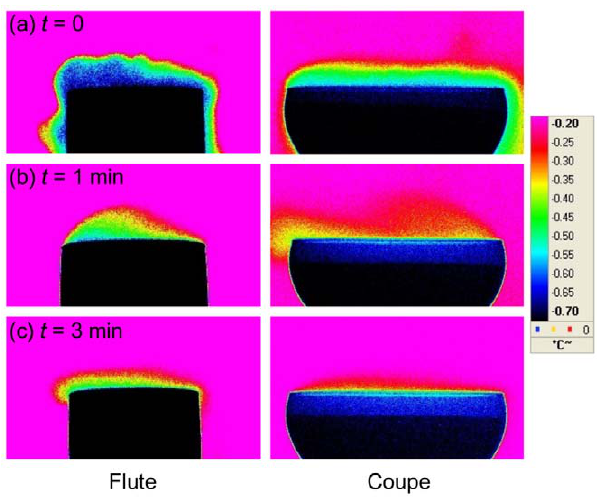
Figure 8. Close-up on gaseous CO 2 desorbing above both glass types. False color IR time-sequences showing close-up snapshots of CO 2 clouds desorbing above the flute and the coupe, respectively, immediately after pouring (a), 1 min after pouring (b), and 3 minutes after pouring (c); By using the color scale which provides a correspondence between the relative abundance of gaseous CO 2 and the temperature detected by the IR sensor of the camera after absorption by the gaseous headspace above glasses, it clearly appears that gaseous CO 2 is always more concentrated above the flute than above the coupe.